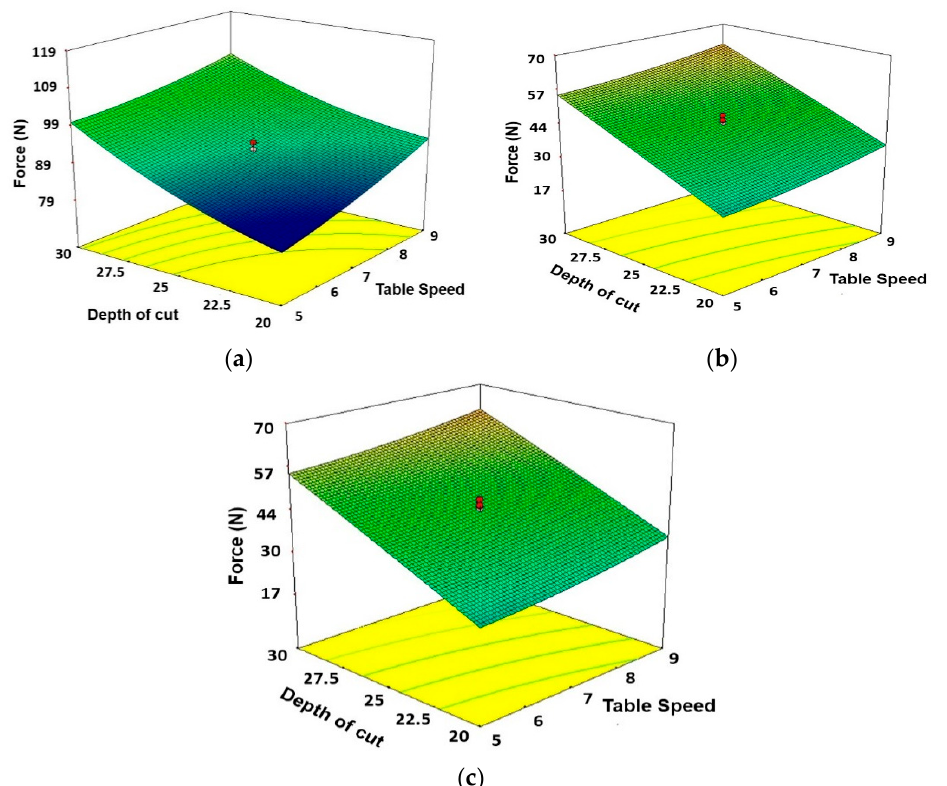
Figure 4. 3D Surface plots showing the effects of depth of cut and table speed on forces for ( a ) Dry, ( b ) Wet, and ( c ) MQL conditions. Units of table speed and depth of cut are ‘m/min’ and ‘µm’, respectively.